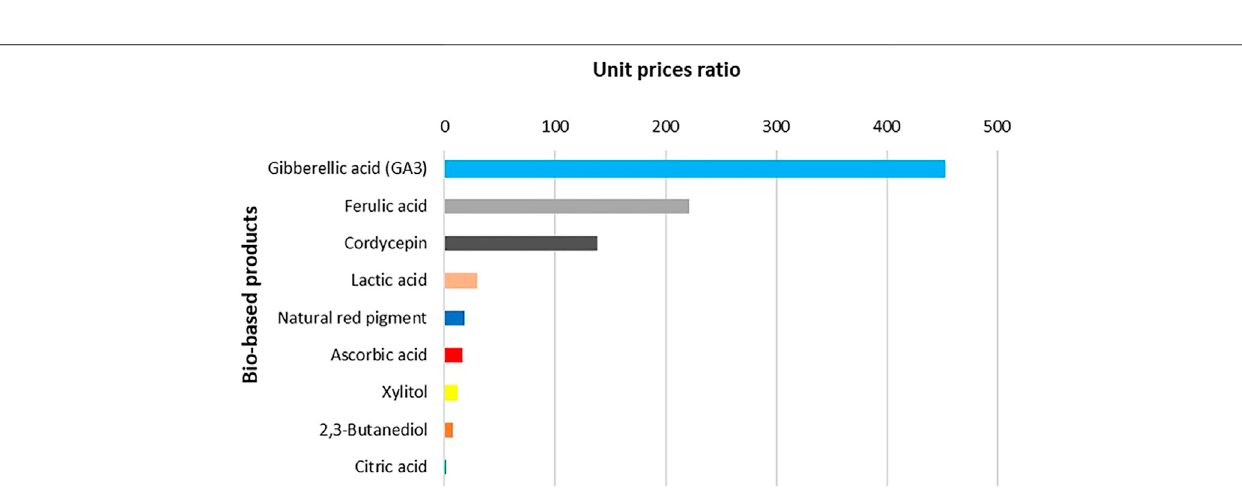
Frontiers in Bioengineering and Biotechnology |